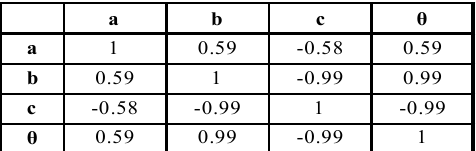
Table 2. Correlation coefficients of Model 1: a, b, c and θ